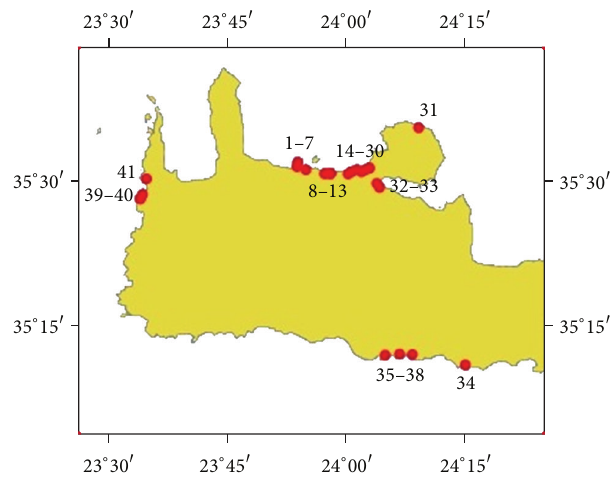
Figure 1: The selected coastal locales.